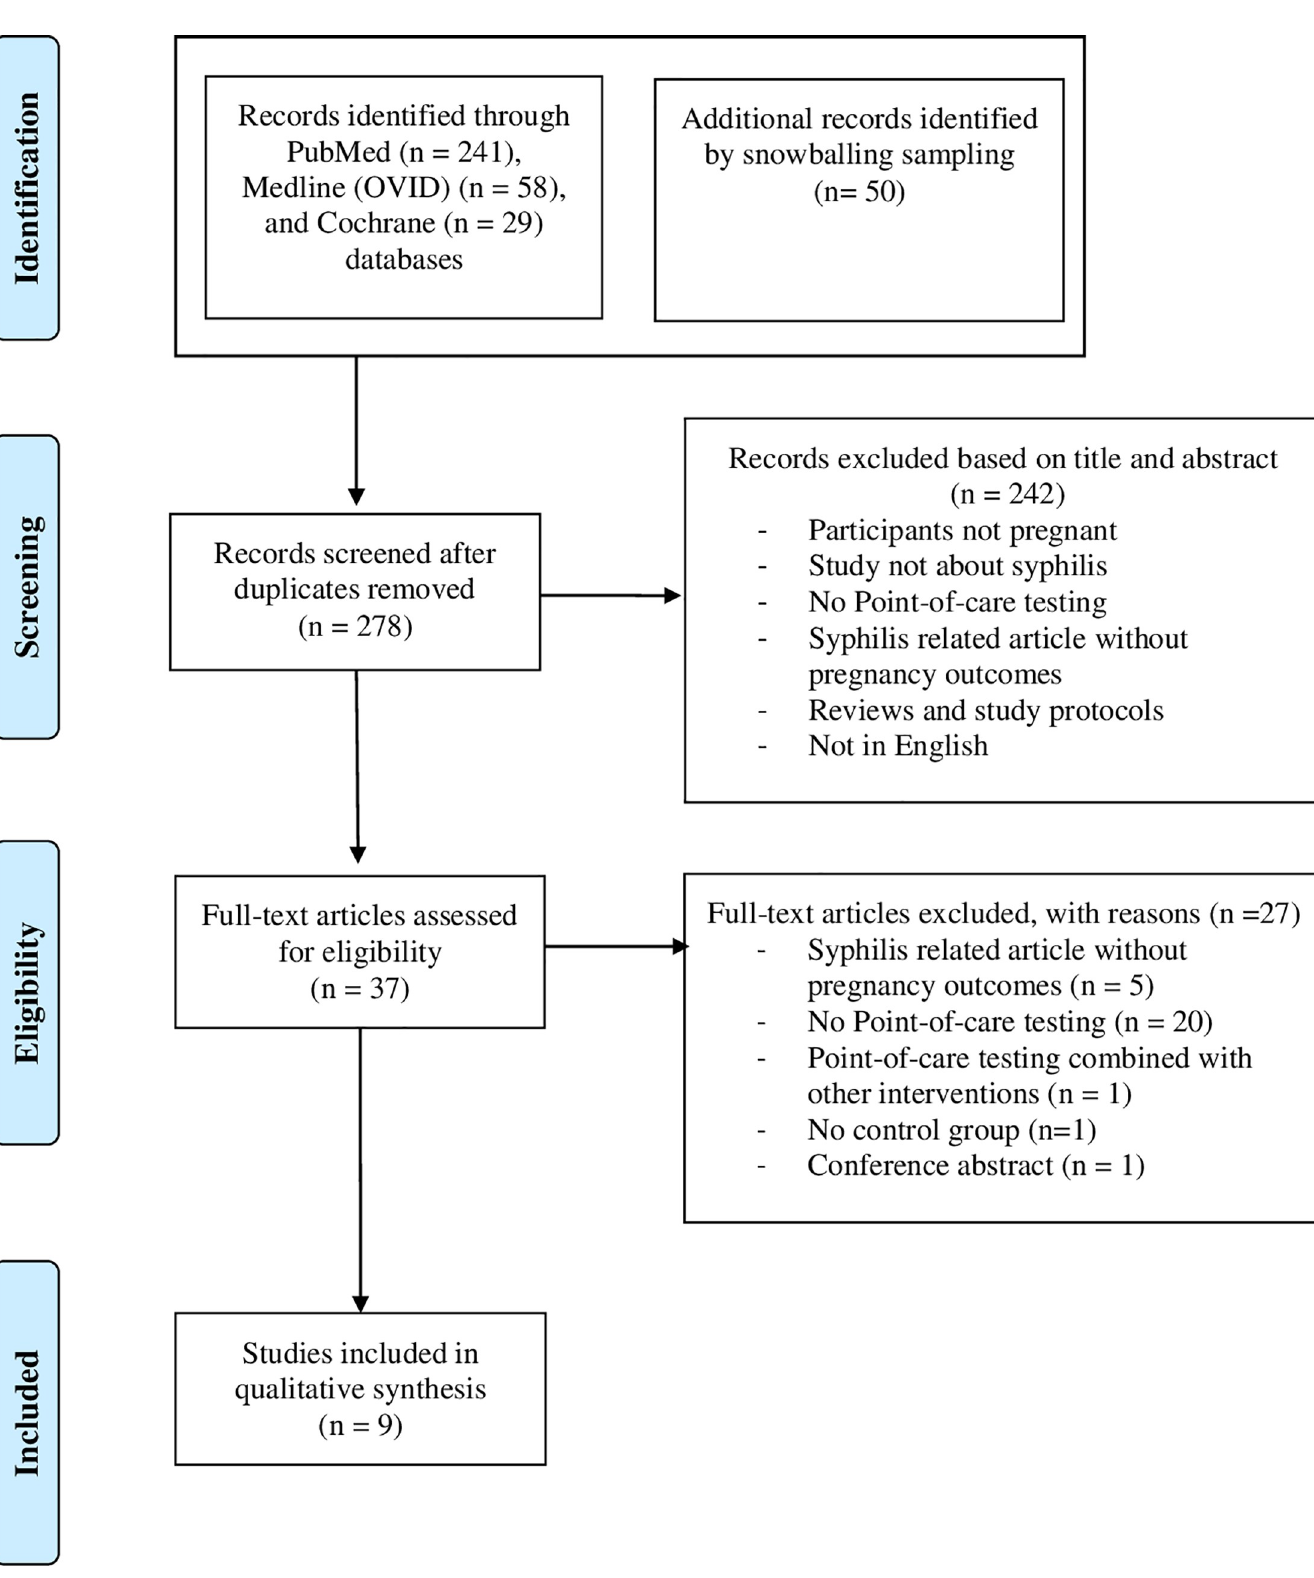
PLOS ONE | https://doi.org/10.1371/journal.pone.0247649 March 25,